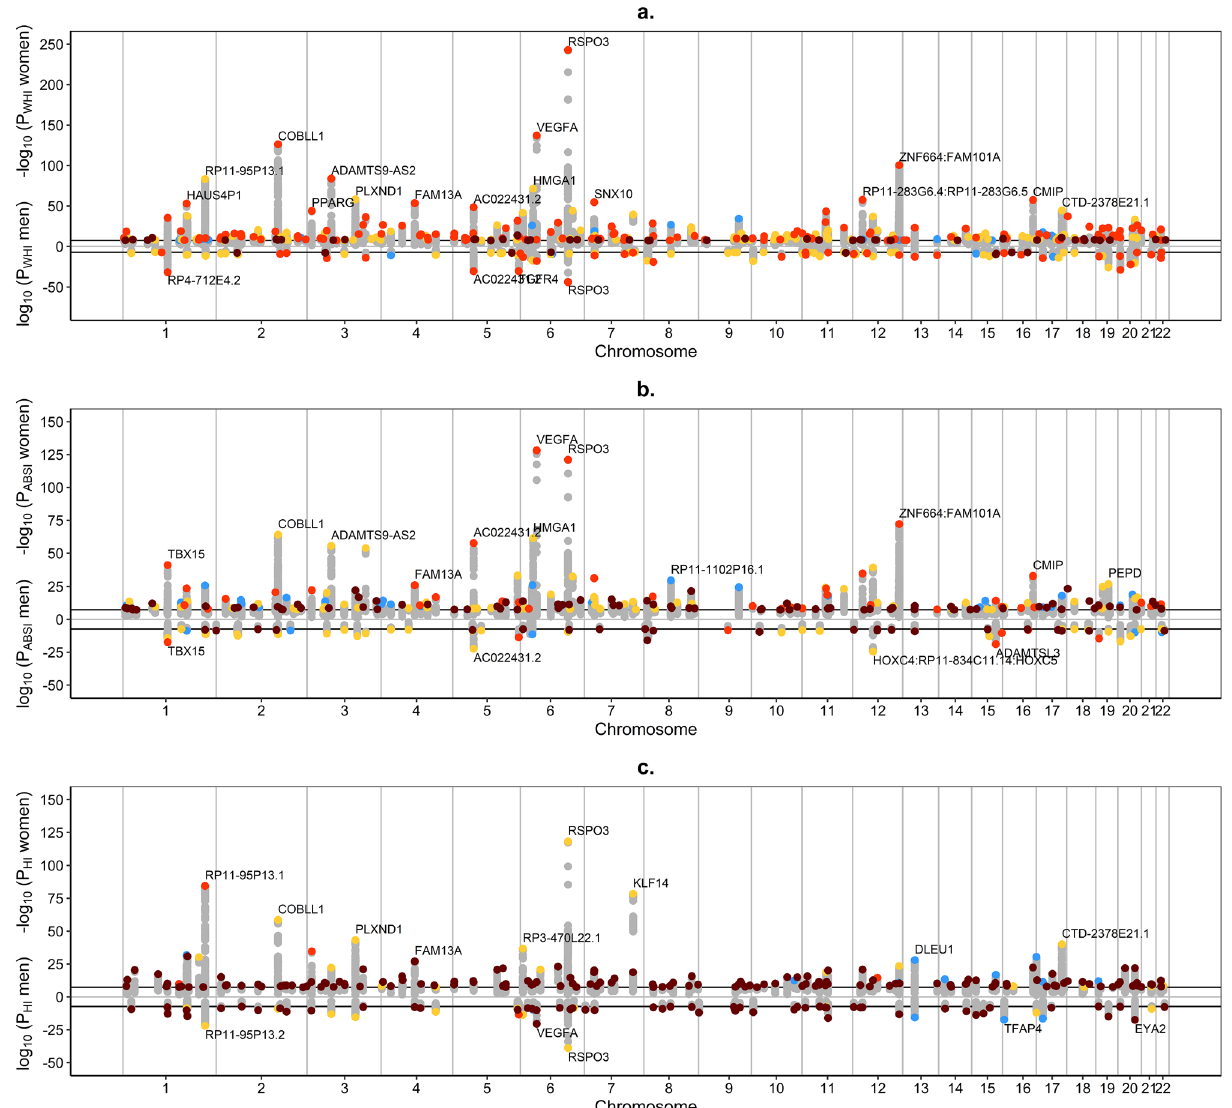
Figure 1. Miami plots of candidate SNPs identified for allometric body-shape indices in women and men. ( a ) GWAS of waist-to-hip index calibrated for UK Biobank participants (WHI UKB ); ( b ) GWAS of a body shape index calibrated for UK Biobank participants (ABSI UKB ); ( c ) GWAS of hip index calibrated for UK Biobank participants (HI UKB ); P- P -values were derived from BOLT-LMM infinitesimal models; SNP-single nucleotide polymorphism; horizontal lines correspond to the genome-wide significance cut-off P = 5*10 –8 . Genomic risk loci with their corresponding locus lead SNPs were identified with FUMA v1.3.6a. All candidate SNPs are shown in grey, locus lead SNPs are colour-coded as follows: (grey circle) candidate SNPs; (dark red circle) novel genomic risk locus identified in the current study, with no previously reported candidate SNPs; (orange circle) genomic risk locus with a previously reported locus lead SNP; (yellow circle) genomic risk locus with a previously reported SNP in strong linkage disequilibrium (LD) with the locus lead SNP at r 2 ≥ 0.6; (cyan circle) genomic risk locus with previously reported other candidate SNP. SNPs identified for allometric body-shape indices in the current study were matched against SNPs reported in the NHGRI-EBI GWAS Catalog 11 (https:// www. ebi. ac. uk/ gwas/ home, accessed on 07/04/2021) in association with the corresponding traditional body- shape index (with or without adjustment for body mass index, BMI), i.e. the waist-to-hip ratio for WHI